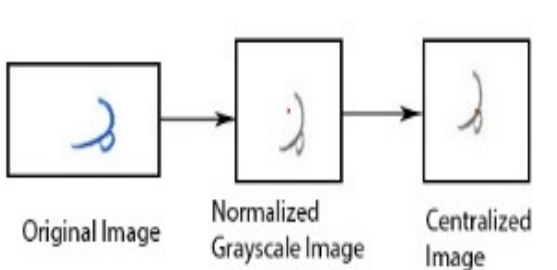
Fig. 5: Resultant Character after Preprocessing